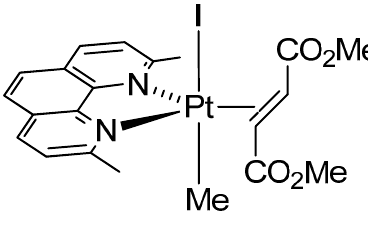
Figure 1. Structure of complex I .